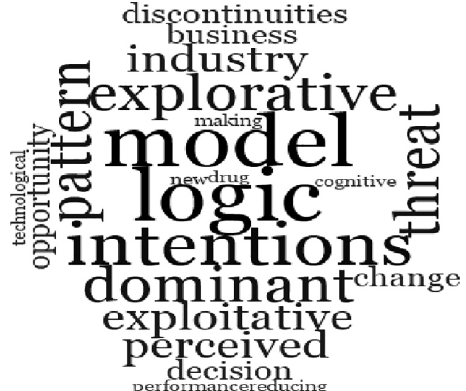
Figure 10. The 5th